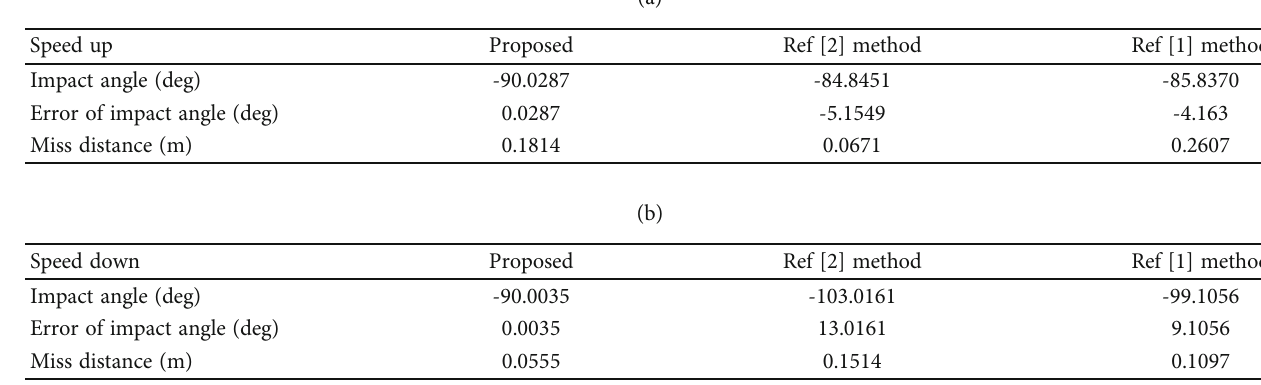
Table 9: Simulation result for Case